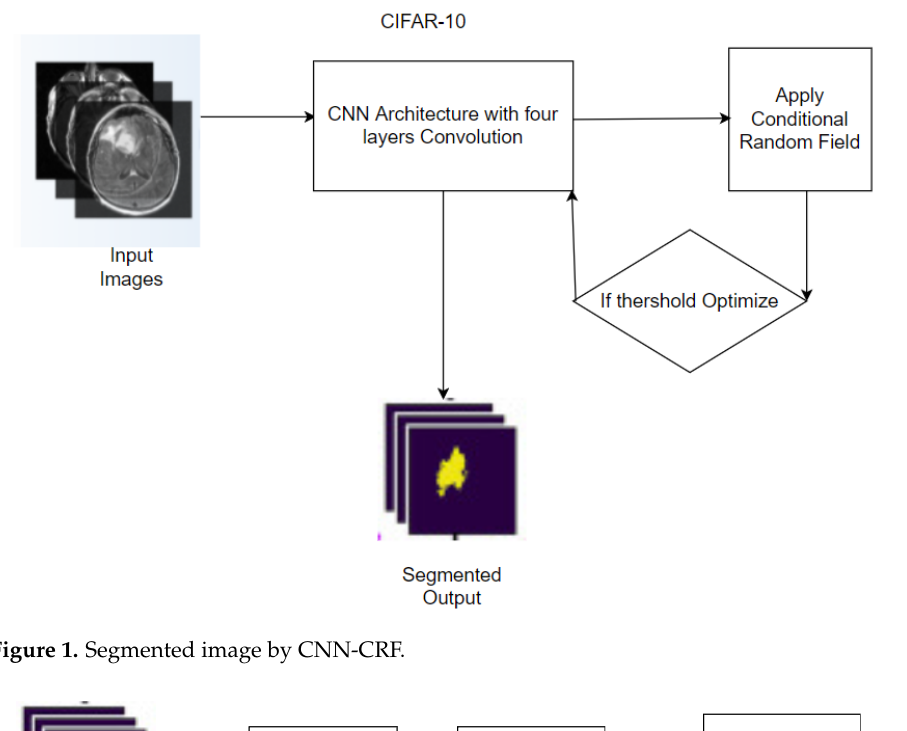
Figure 1. Segmented image by CNN-CRF.